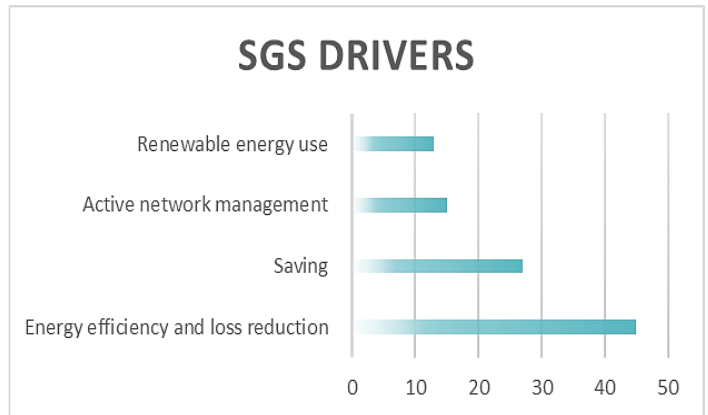
Figure 8. Smart grid system drivers.